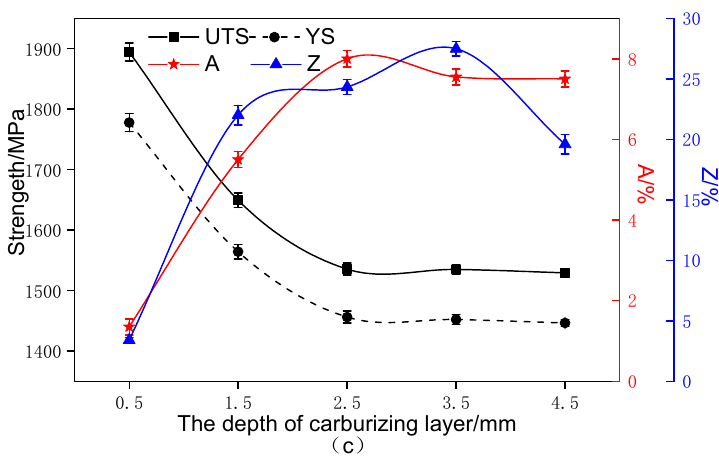
Figure 15. Comprehensive performance of the novel solid-solution carburizing process: ( a ) carbon content; ( b ) microhardness; ( c ) mechanical properties.